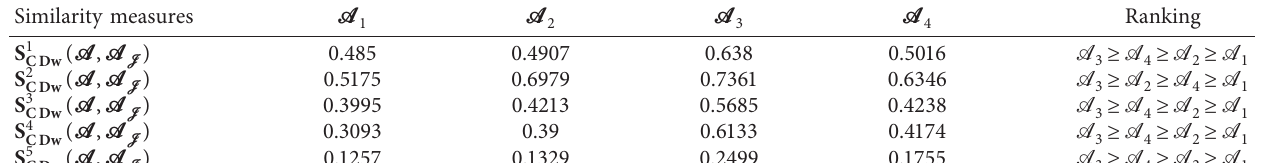
Table 2: Calculation of explored WSMs based on λ � 1 and ( η